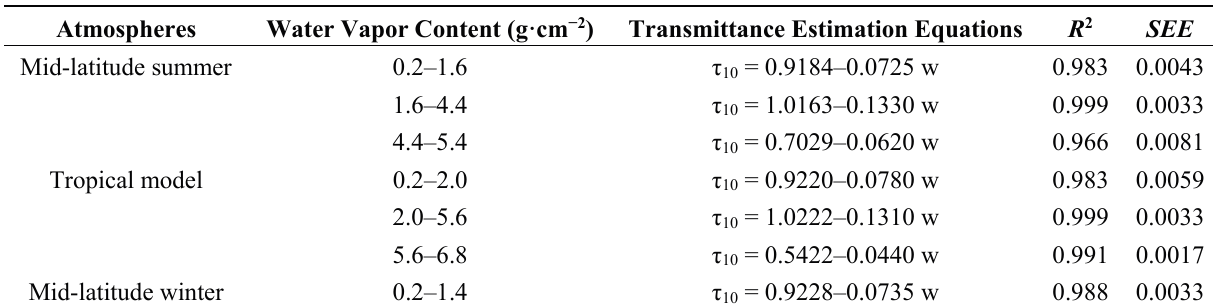
Table 6. Estimation of atmospheric transmittance for the Landsat 8 TIRS bands. SEE, standard estimation